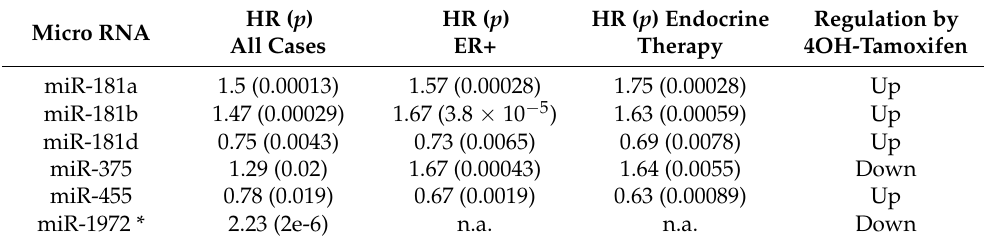
Table 3. Kaplan–Meier overall survival analysis for significantly 4OH-tamoxifen-regulated microR- NAs using the KM-plotter website [44] and the METABRIC [45] and pan-cancer (miR-1972) dataset. Hazard ratio (HR) for high expression of the microRNA, as well as log-rank p, is shown. * Please note that results for miR-1972 might be unreliable, as the median expression was very low. n.a.: not available. Micro